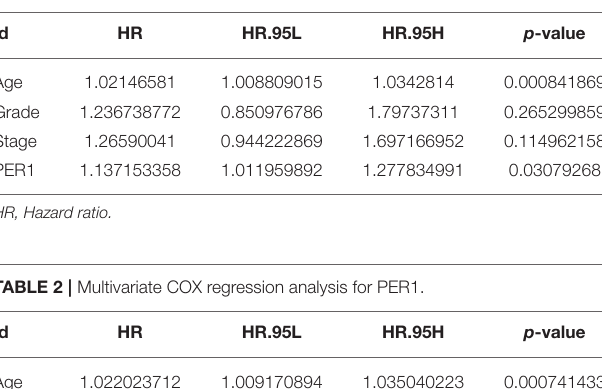
TABLE 1 | Univariate COX regression analysis for PER1.